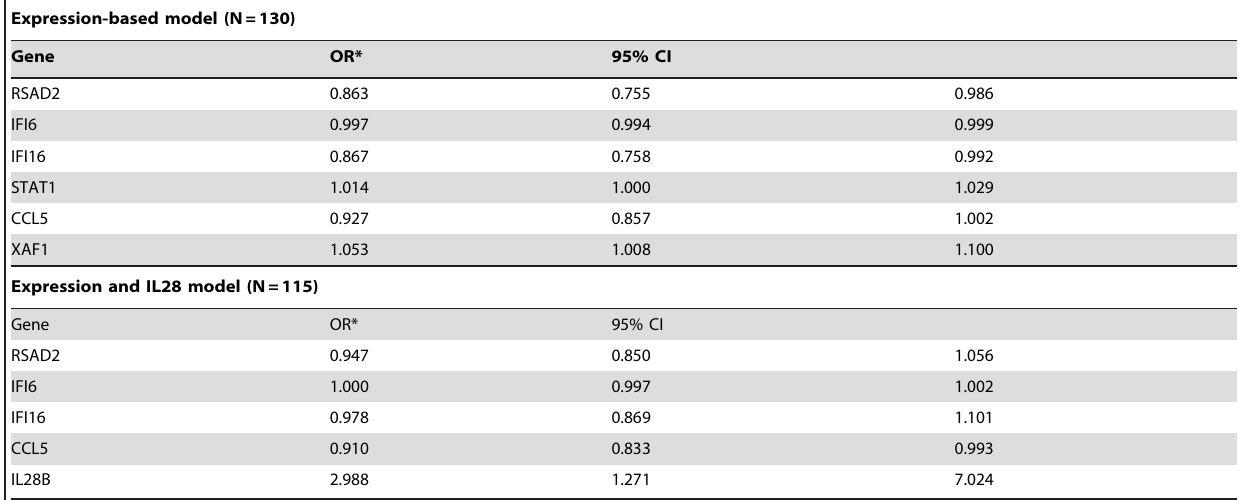
Table 5. Logistic regression modeling of patient data.